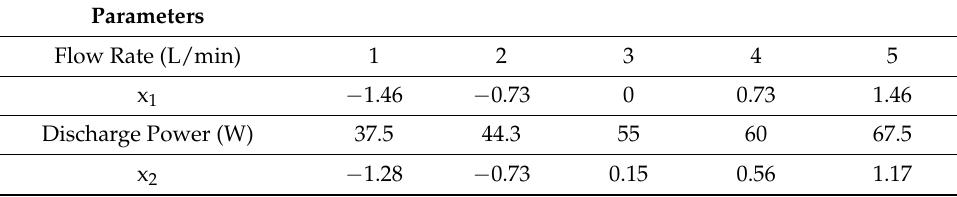
Table 1. Schematic diagram of the DBD reactor. The chosen process parameters and their standard- ized